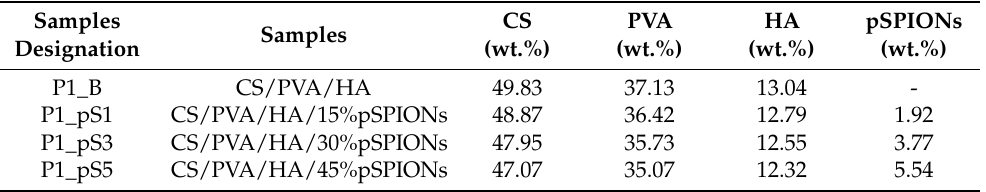
Table 2. Solid content of the CS/PVA/HA/pSPIONs pastes produced by adding pSPIONs to paste P1 at three different weight percentages (15, 30, and 45 wt.%) relative to the total amount of HA in the paste.